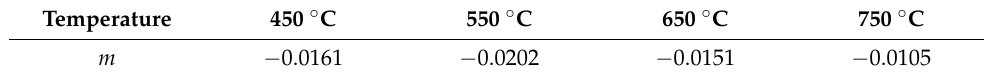
Table 3. The strain rate sensitivity value at different aging temperatures. Temperature